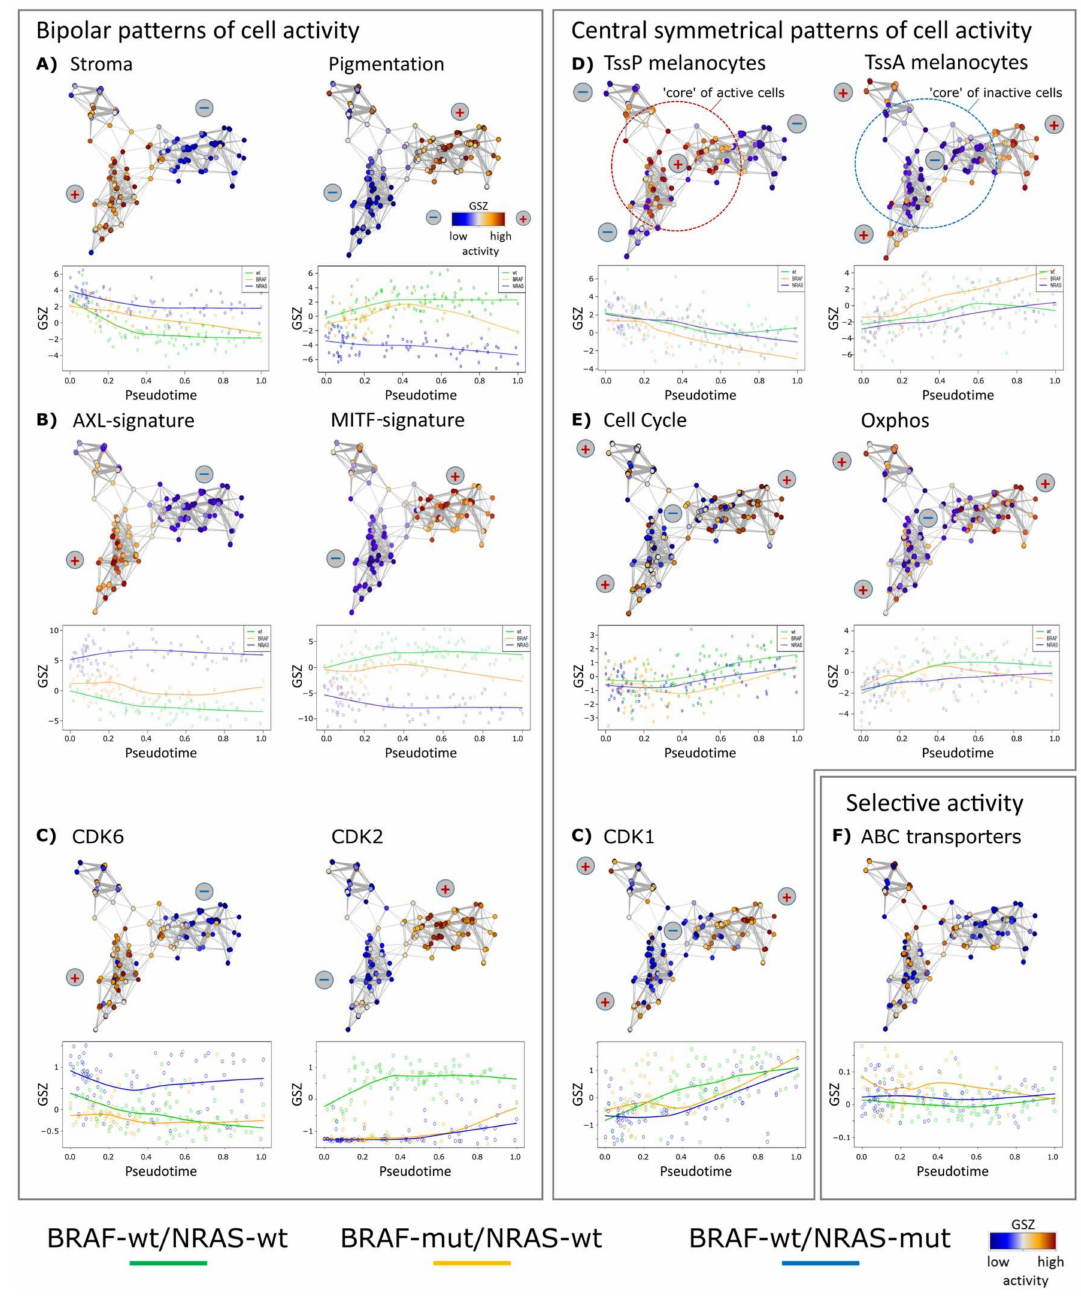
Figure 2. Changes of melanoma expression signatures with PT. Melanoma short-term cultures were analyzed by single-cell RNA-seq and subjected to PT analysis using Wanderlust algorithm. ( A ) Stromal and pigmentation signature. ( B ) AXL and MITF signatures show a virtually bipolar characteristics with high levels of AXL in the NRAS-mut cells and low levels in the BRAF-mut and wt/wt cells, respectively, also indicated by the plus and minus signs. MITF shows opposite characteristics. ( C ) Gene expression levels of cyclin-dependent kinases CDK6 and CDK2 show bipolar, CDK1 central symmetrical activation patterns, respectively. ( D ) Mean expression of genes attributed to poised (TssP) promoters decreased with PT, while that with active (TssA) promoters increased. ( E ) Expression of genes related to cell cycle and oxidative phosphorylation (oxphos) both increased with PT, however, in a bimodal way with a delay of cell cycle activity and a plateau phase of oxphos. Gene sets were taken from gene ontology [26] and hallmarks of cancer [25] repositories and from two further studies on stromal and MITF/AXL signatures, respectively [13,27]. ( F ) ABC-transporter genes are selectively expressed across the melanoma cells in agreement with